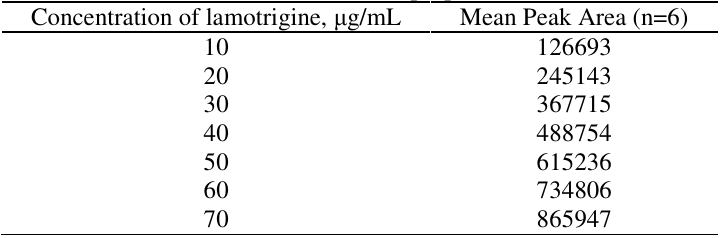
Table 1. Calibration of the proposed